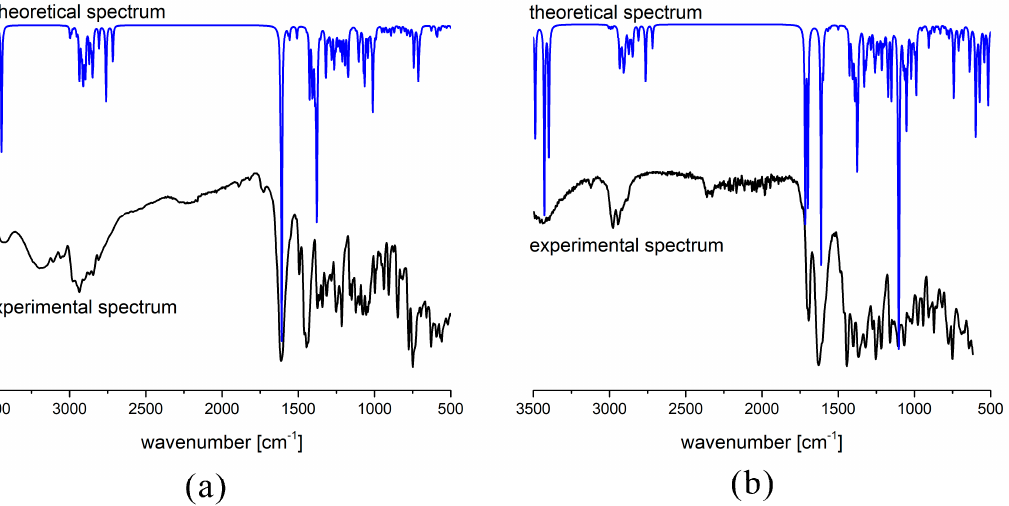
Figure 2. Experimental and theoretical (at M05-2X/6-311++G(d,p) level of theory) IR spectra of ( a ) LSD base and ( b ) LSD